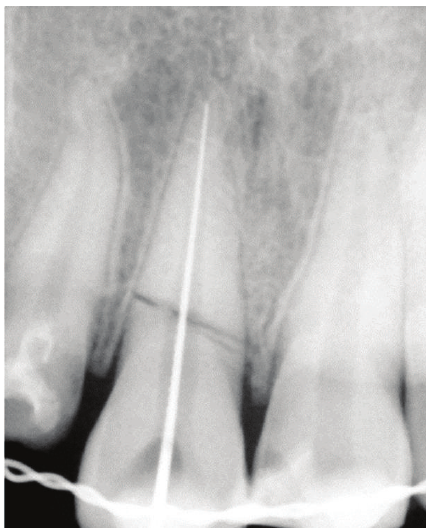
Figure 10: MTA placement.